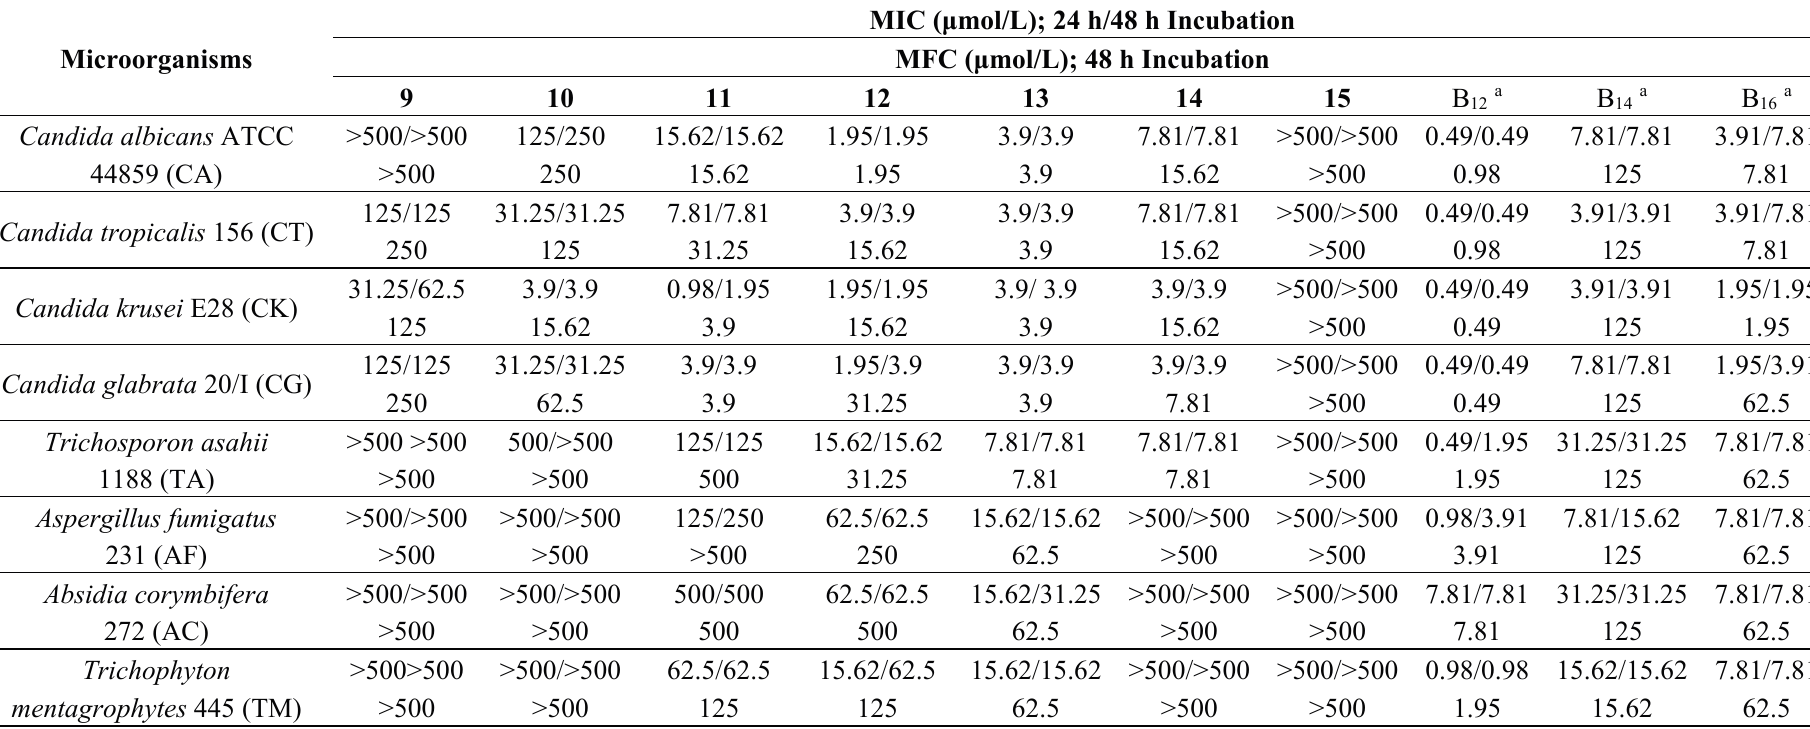
Table 2. Minimum inhibitory/fungicidal concentrations of the prepared compounds ( 9 – 15 ) and selected derivatives of N -benzalkonium (B 12 –B 16 ). The in vitro activities were determined on a panel of eight fungal strains. Microorganisms